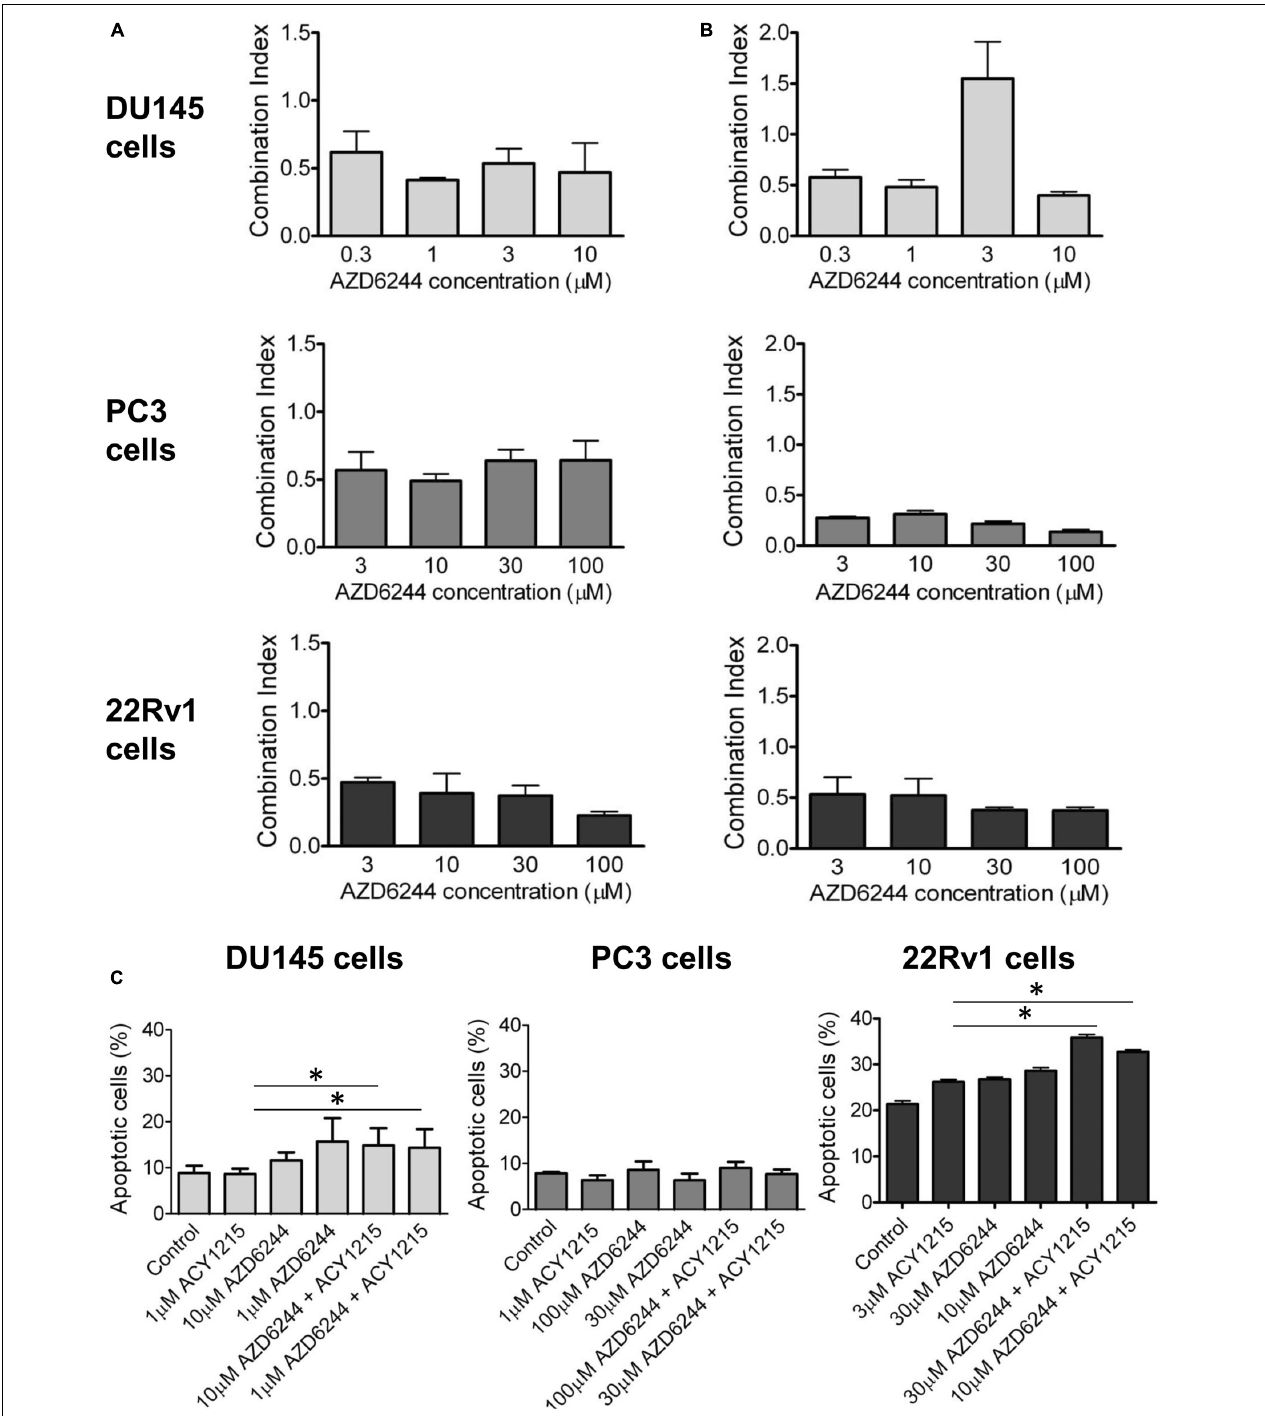
FIGURE 1 | Analysis of the drug interaction and apoptotic response in prostate carcinoma cells exposed to the MEK inhibitor AZD6244 and to the HDAC inhibitor ACY1215. Cell sensitivity to increasing concentrations of selumetinib (AZD6244) and ricolinostat (ACY1215) or to their combination was assessed by growth inhibition assays in DU145, PC3, and 22Rv1 cells. Cells were exposed for 72 h to each drug alone or to the drug combination with 1 µ M (for DU145, PC3 cells) or 3 µ M (for 22Rv1 cells) ACY1215. Histograms of the mean of Combination Index values of at least 3 independent experiments are shown (A) . A 24 h pre-treatment with 1 µ M (for DU145, PC3 cells) or 3 µ M (for 22Rv1 cells) ACY1215, was followed by 48 h co-incubation with AZD6244. Histograms of the mean of Combination Index values of at least 3 independent experiments are shown (B) . Cells were exposed to single agents or to their combination according to a simultaneous schedule for DU145 cells and 24 h pre-treatment with ACY1215 followed by 24 h co-incubation with AZD6244 for PC3 and 22Rv1 cells, and harvested 48 h after treatment start for analysis of apoptosis by Annexin V binding assay (C) .